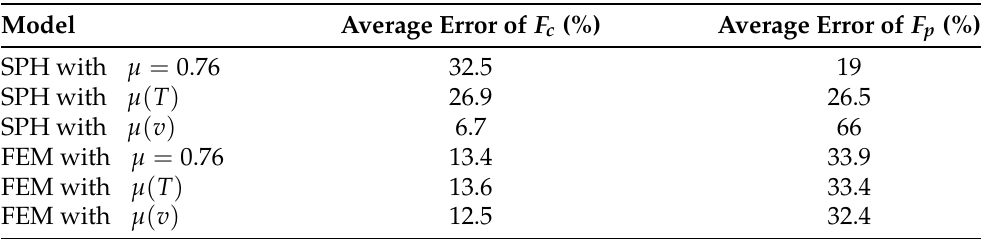
Table A1. Force prediction errors of SPH and FEM for AISI 1045 using different friction coefficients.